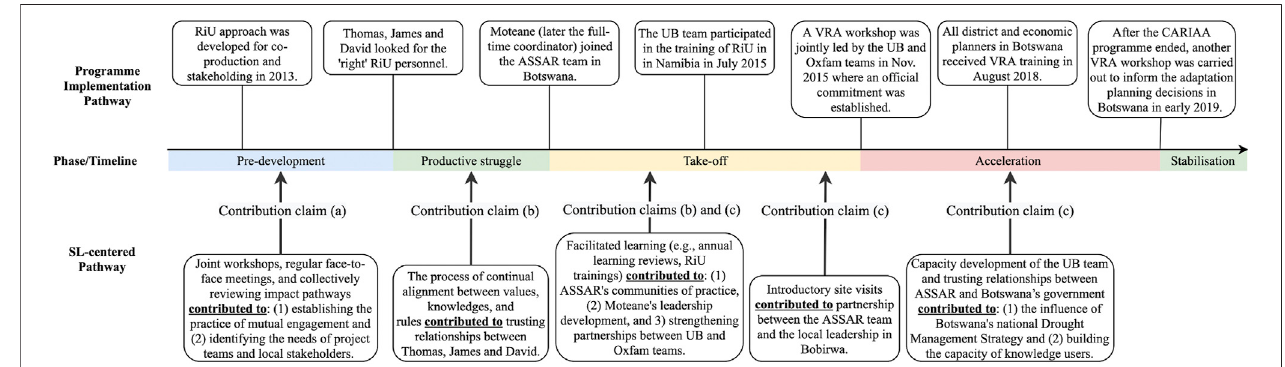
FIGURE6| Asimpli fi eddiagramofthecontributionclaimsandchangeprocessintheASSARBotswanacase.Thecontributionclaimsindicatedinthis fi gureare(a) tailoredworkshopscontributedtomutualengagement,(b)prolongedengagementcontributedtodevelopingtrustacrosspartnerorganizations,and(c)ongoinglearning contributed to new modes of pursuing research at UB and drought management in the region. The evidence on each contribution claim is presented in Table 3 ; Supplementary Material S2 .